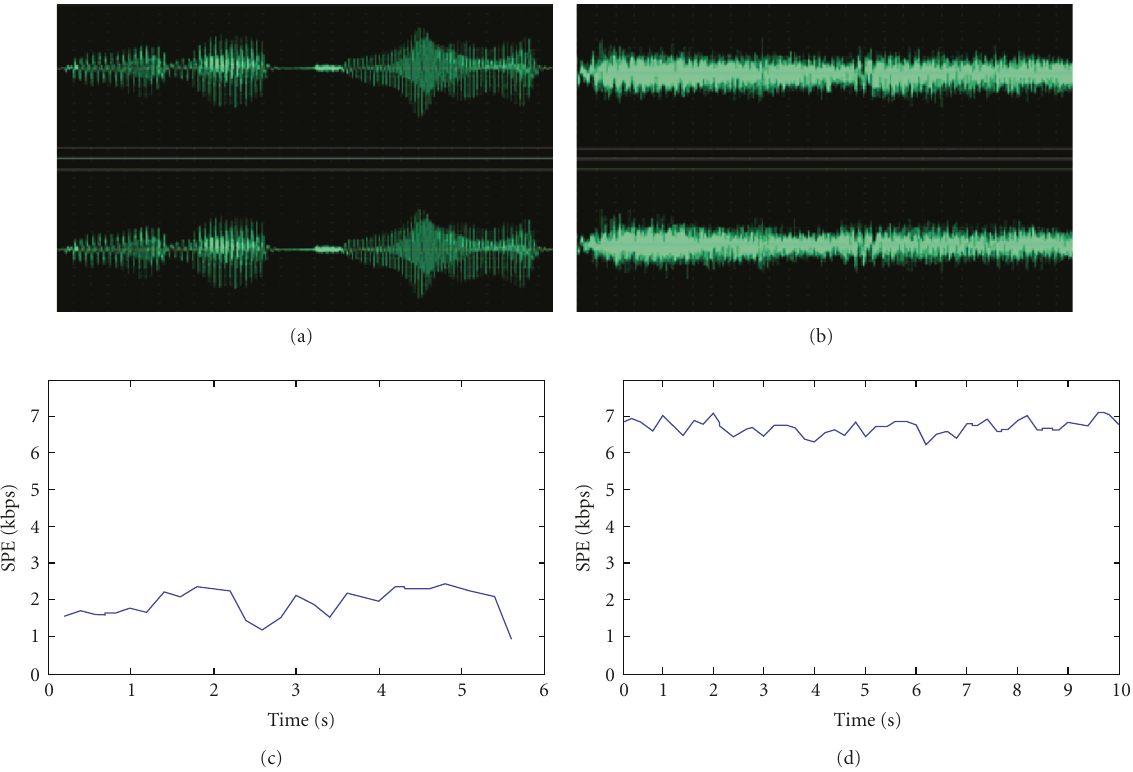
Figure 16: SPE of es02 (speech) and sc03(pop). (a): waveform of es02; (b): SPE curve of es02; (c): waveform of sc03; (d): SPE curve of sc03.